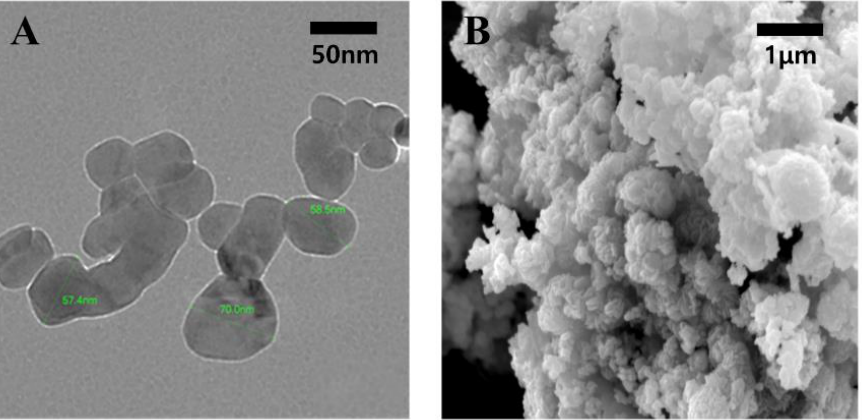
Figure 1. TEM and SEM analyses of CuO NPs: ( A ) TEM analysis at an accelerating voltage of 120 kV (magnification 80,000); ( B ) SEM analysis at an acceleration voltage of 15 kV (magnification, 20,000 × ). 2.2. Total Cell Count and the Percentages of PMNs, Lymphocytes, Eosinophils, and Macrophages in BALF of Rats Exposed to CuO